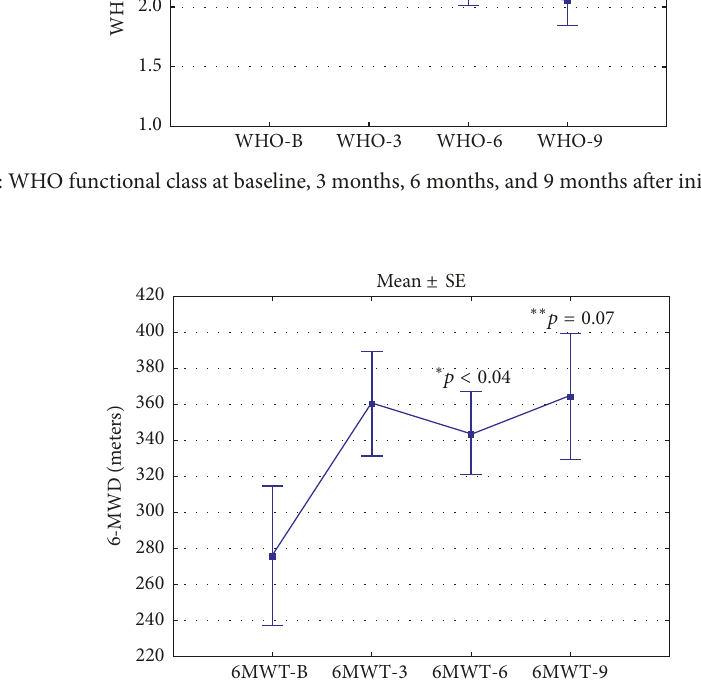
with Cpc-PH when compared to patients with pure PAH.